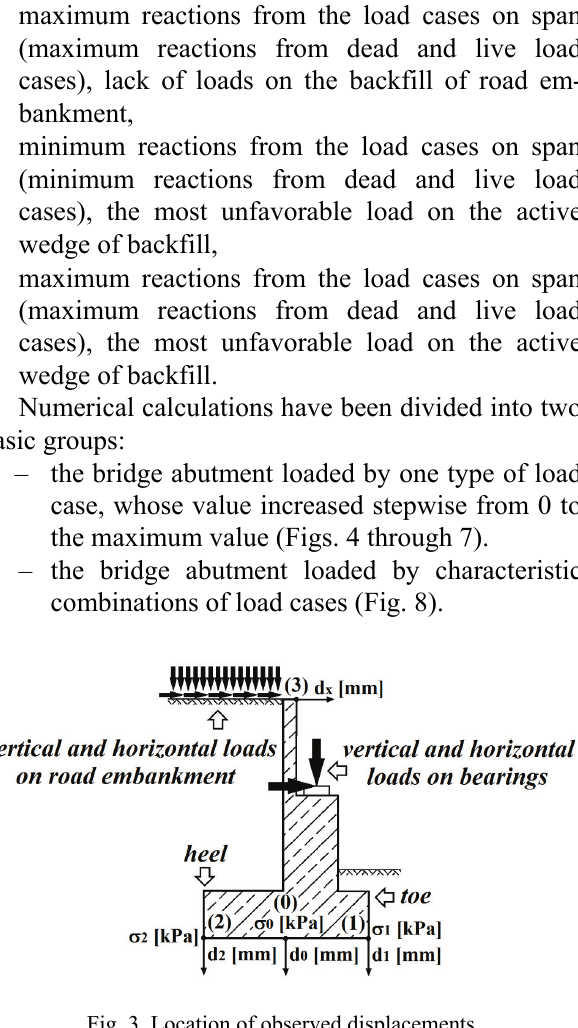
Fig. 3. Location of observed displacements